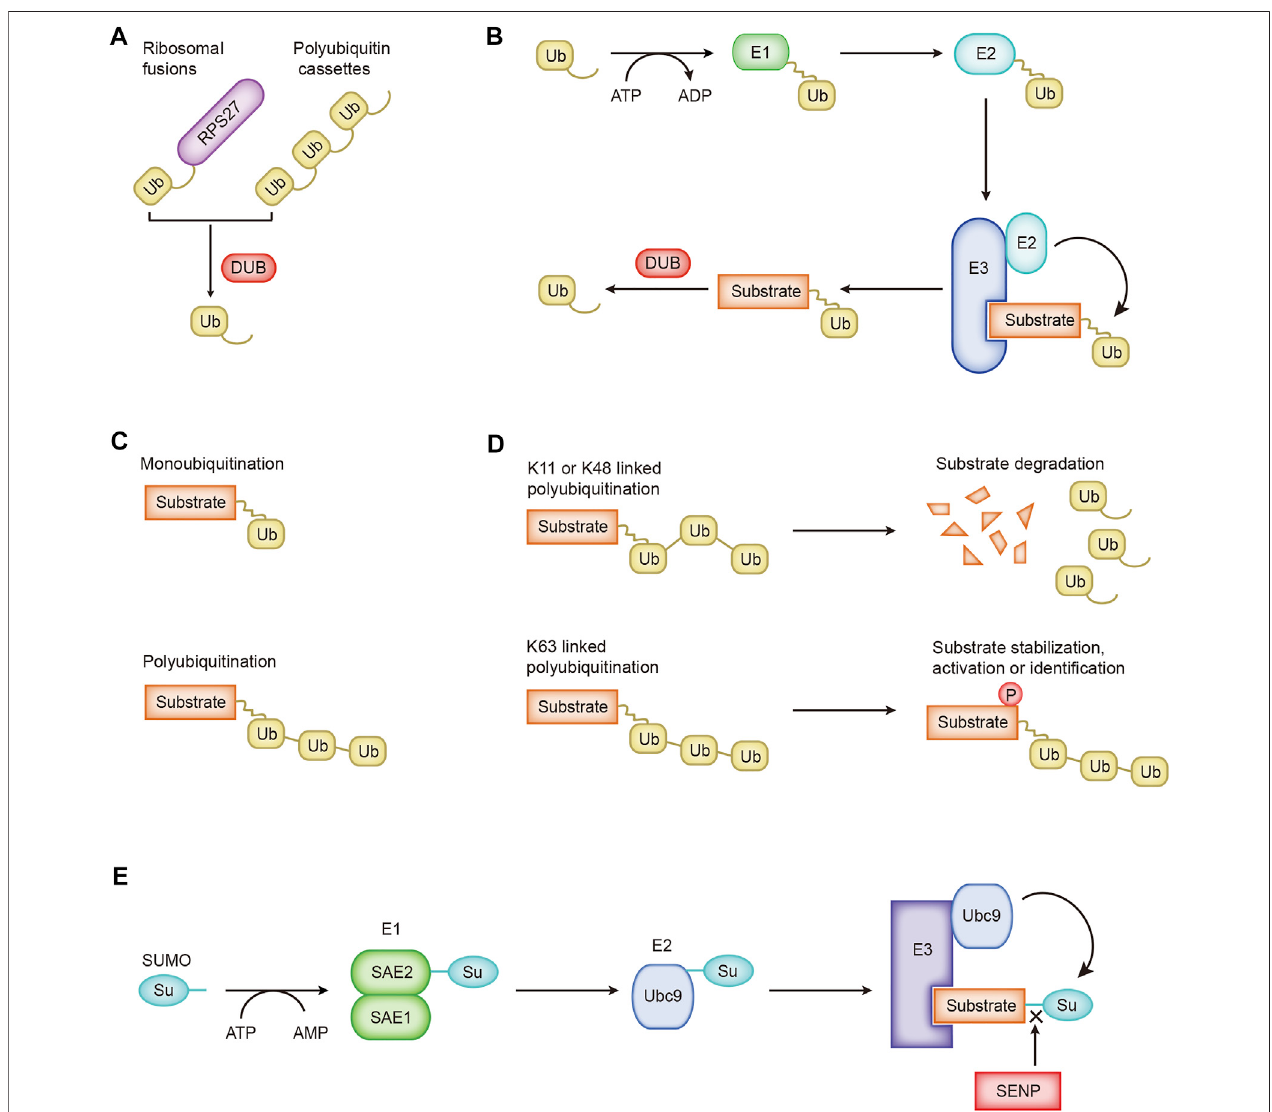
FIGURE 1 | The processes of ubiquitination and SUMOylation. (A) Cells obtain ubiquitin from ribosomal fusions and polyubiquitin cassettes. (B) The cascade of ubiquitin transfer. (C) Different forms of ubiquitin are linked to the substrate. (D) Regulation of K11-, K48-, and K63-linked ubiquitination. (E) The SUMO cascade.